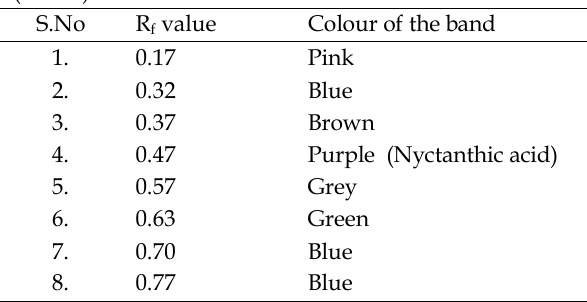
Table 8: R f value and color of peak of fruit extract and standard Nyctanthic acid in Toluene:Ethyl acetate (8.0:2.0) at 366